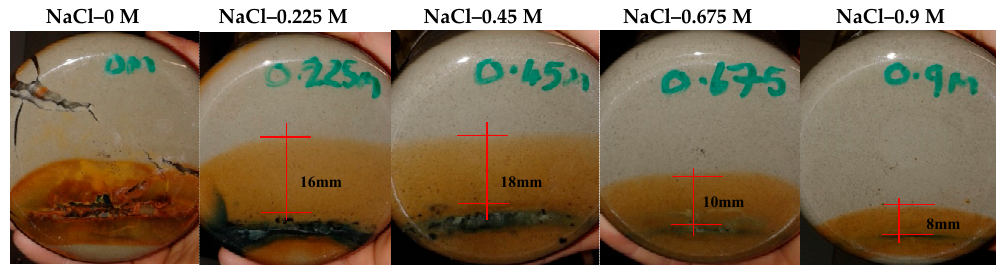
Figure 10. Extent of corrosion integration under ambient conditions after 1-month exposure.